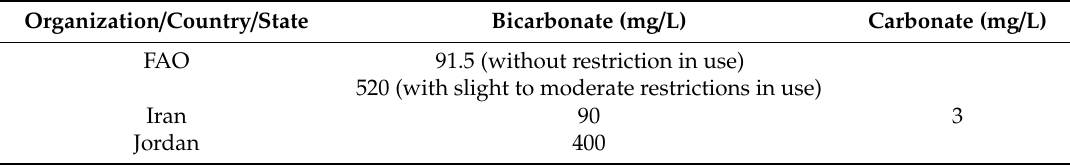
Table 12. Bicarbonate and Carbonate thresholds in agricultural water reuse regulations and